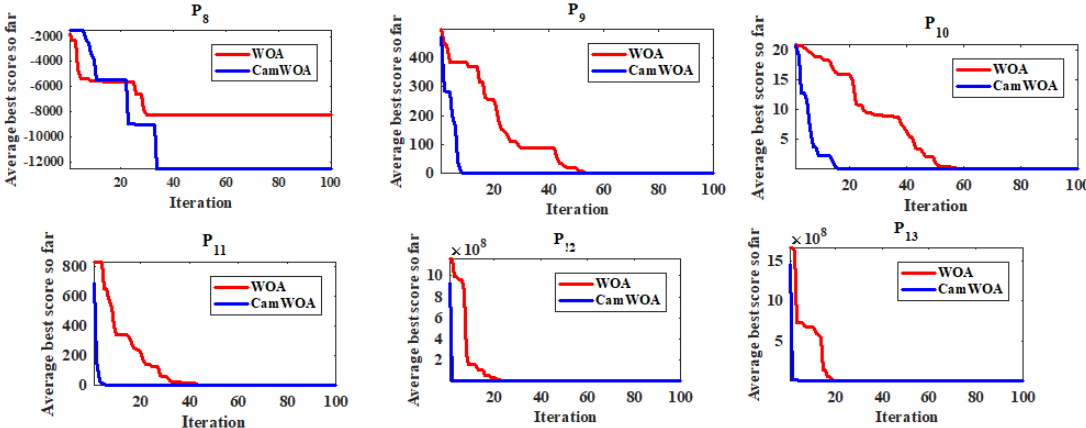
Figure 5. Convergence plot analysis for 30-dimensional functions 𝑝 (cid:2876) , 𝑝 (cid:2877) , 𝑝 (cid:2869)(cid:2868) , 𝑝 (cid:2869)(cid:2869) , 𝑝 (cid:2869)(cid:2870) , 𝑝 (cid:2869)(cid:2871) .